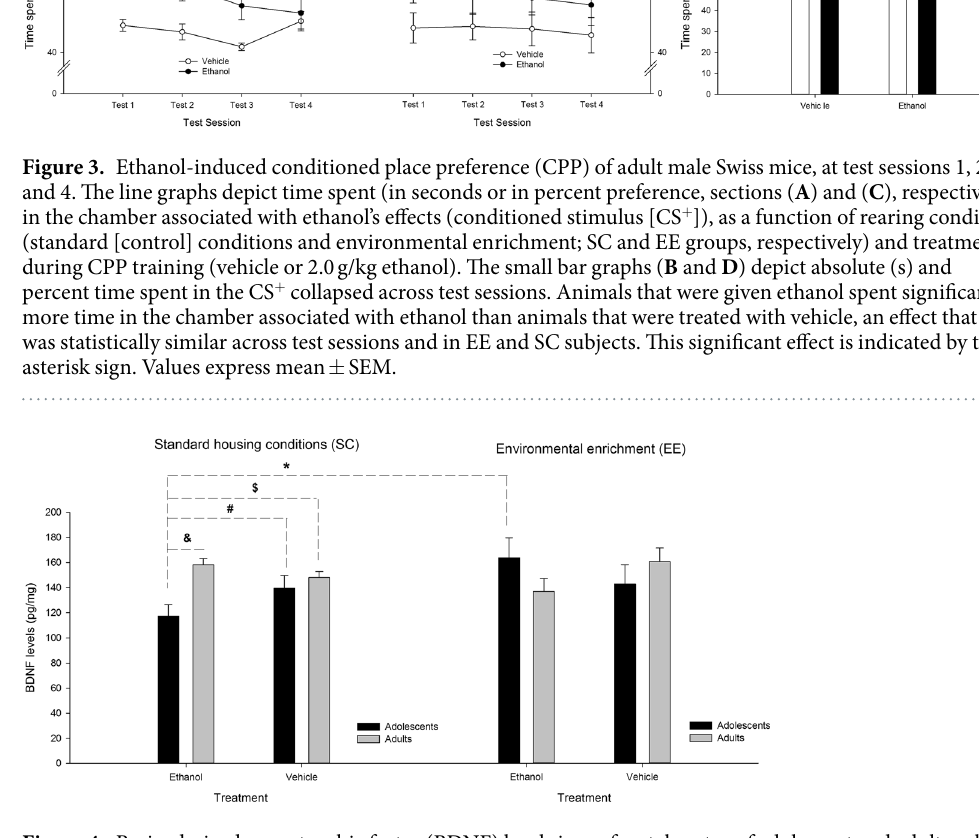
treatment during adolescence was not observed in EE animals (i.e., among ethanol-treated adolescents, BDNF levels were significantly higher in the EE than in the SC group). Throughout habituation and treatment days, body weight was lower in EE adolescent animals than in SC counterparts. The ANOVA indicated a significant main effect of Environmental condition ( F 1,33 = 18.88, η ²p = 0.36, p < 0.001). The ANOVA for adult mice indicated a significant Environmental condition × Day interaction ( F 8,296 = 18.86, η ²p = 0.34, p < 0.001). The three-way Environmental condition × Day × Treatment